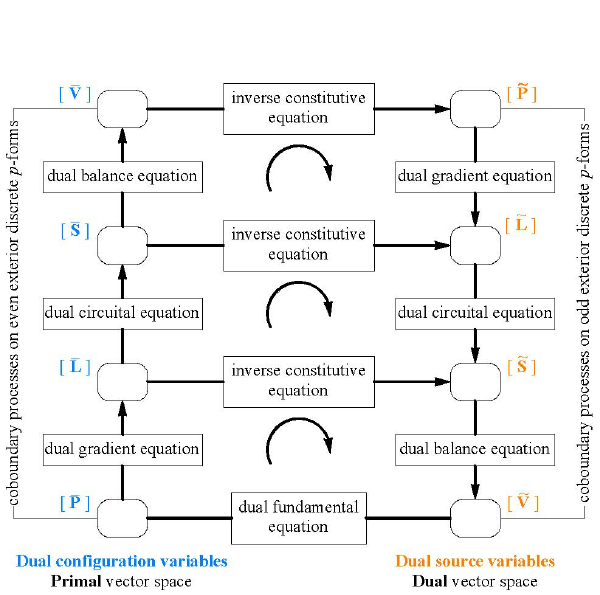
Figure 6: Classification diagram of the physical variables in the dual fundamental